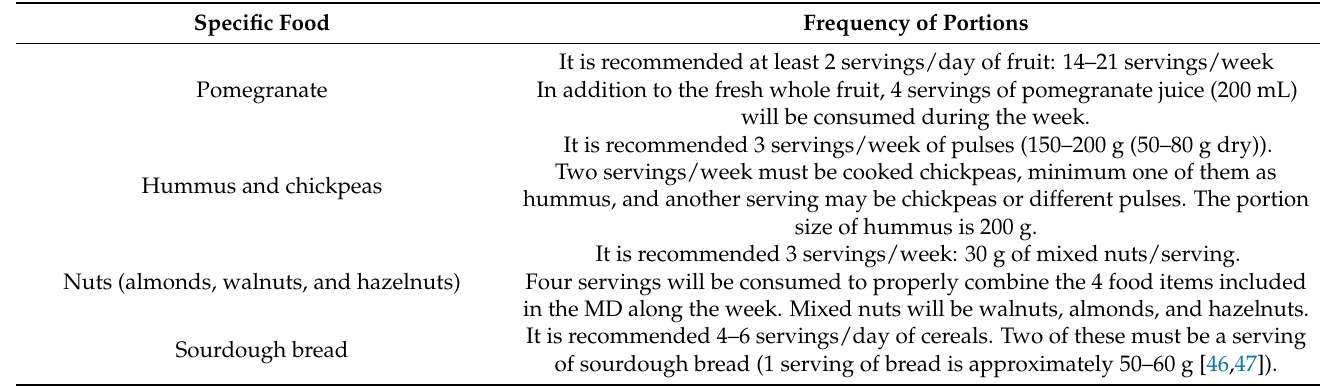
Table 1. Details on the frequency portions of the Mediterranean basin